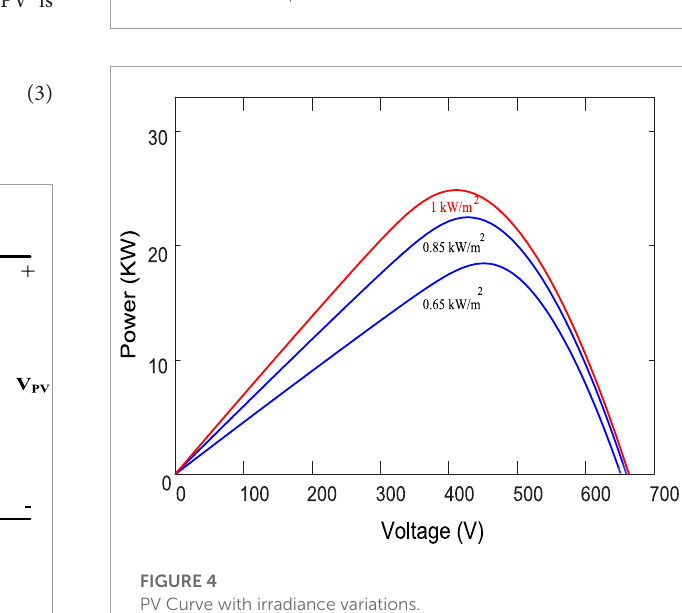
FIGURE 3 PV Curve with temperature variations.